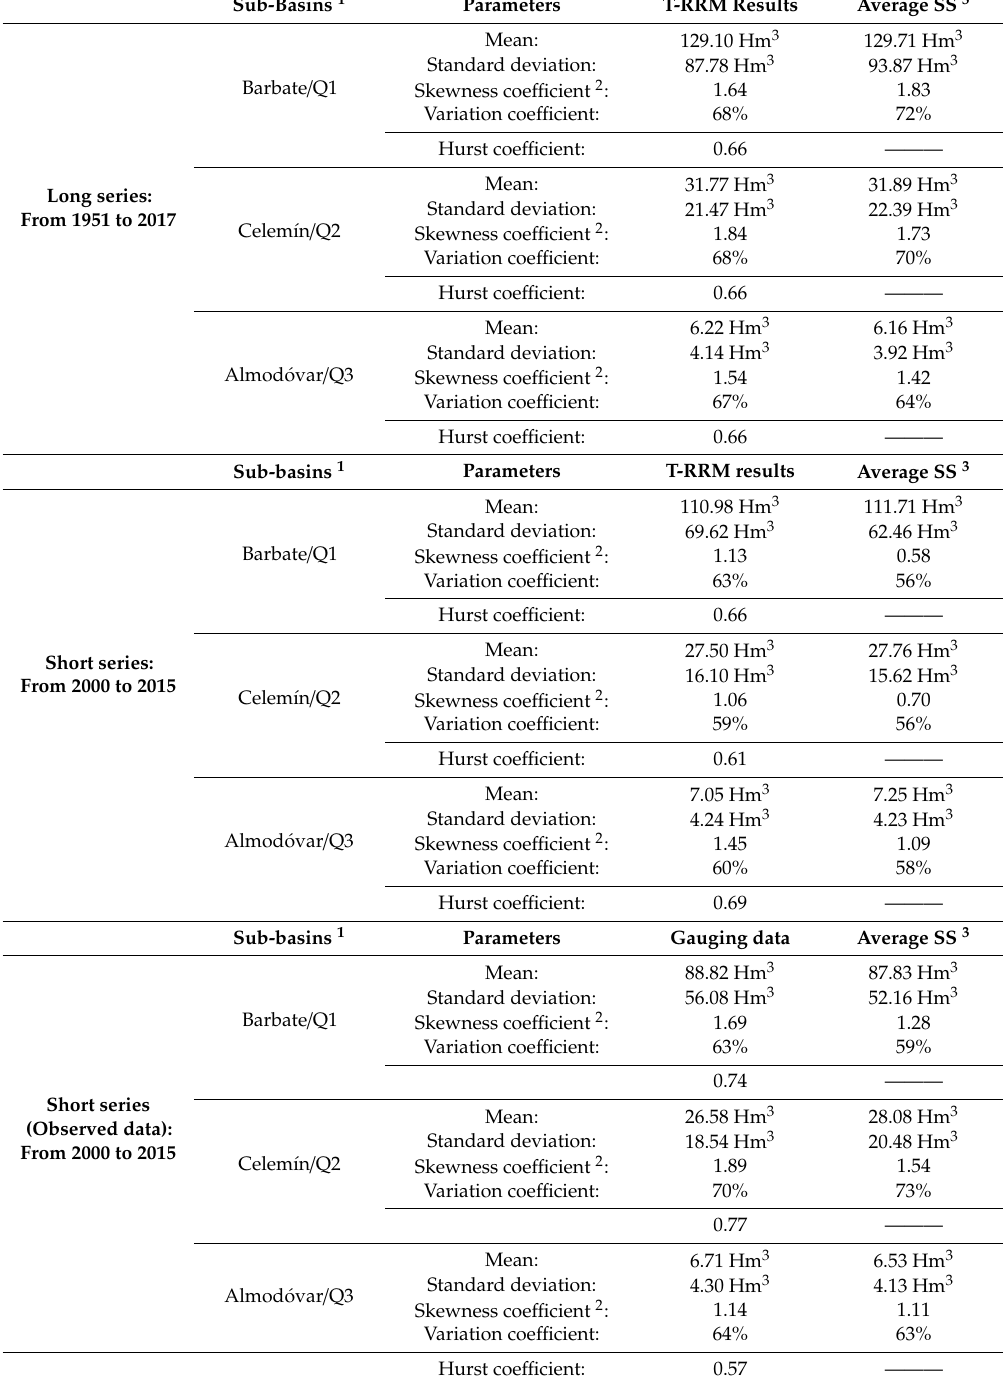
Table 4. Main statistical parameters applied in the development of the 9 causal